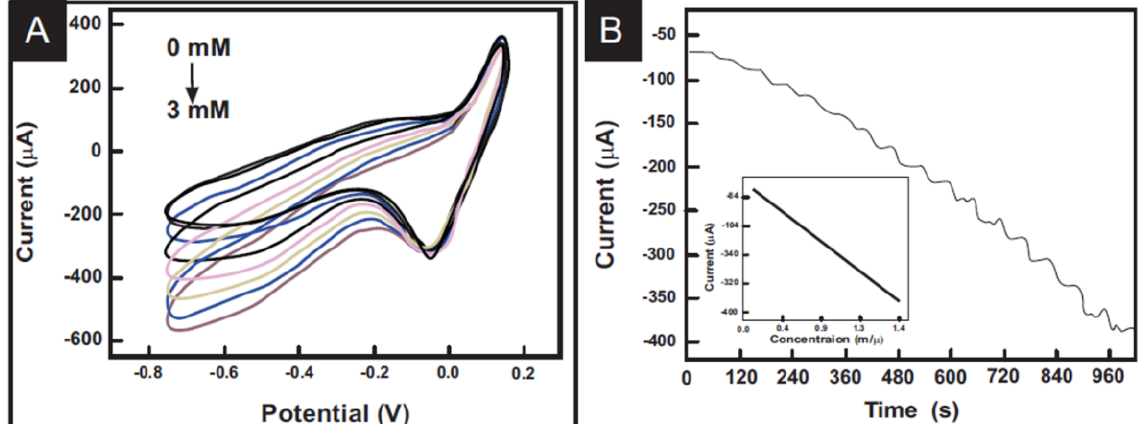
Figure 28. ( a ) CVs of PPy-Ag nanocomposite modified graphite (PPy-Ag/G) electrodes in a 10 mM PBS solution in the absence and presence of H 2 O 2 with different concentrations (from top to bottom: 0, 0.1, 0.5, 1, 1.5, 2, 2.5, 3 mM). Scan rate: 20 mV·s − 1 . ( b ) Amperometric responses of PPy-Ag/G electrodes upon successive addition of 0.1 mM (0.1 to 1.6 mM) in a stirred 10 mM PBS solution. Applied potential: − 0.45 V. The inset shows the corresponding calibration curves of the electrodes in the measured H 2 O 2 concentration range. (Reproduced with permission from [134], Copyright IOP Publishing